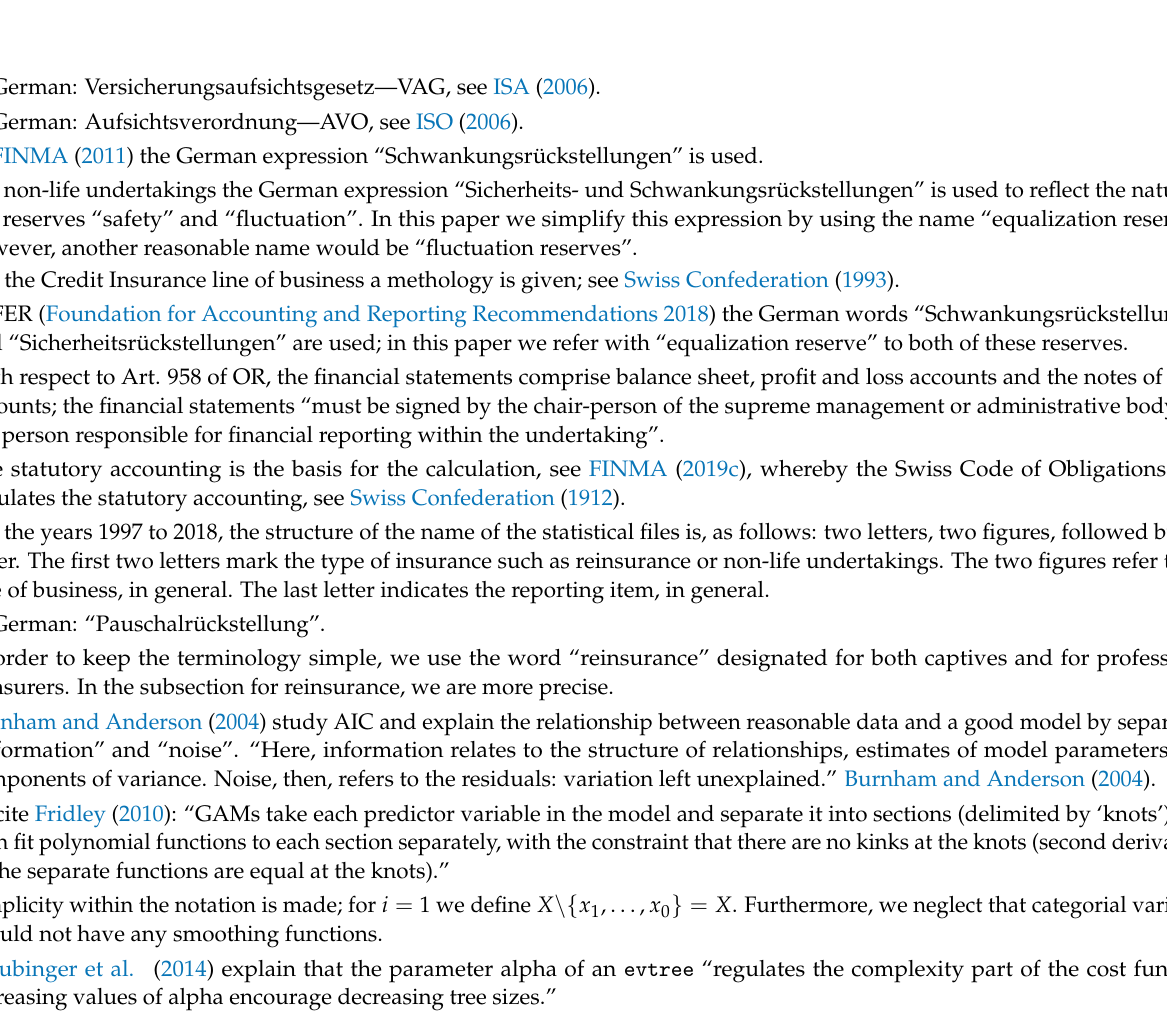
For all explanatory variable the same set A is